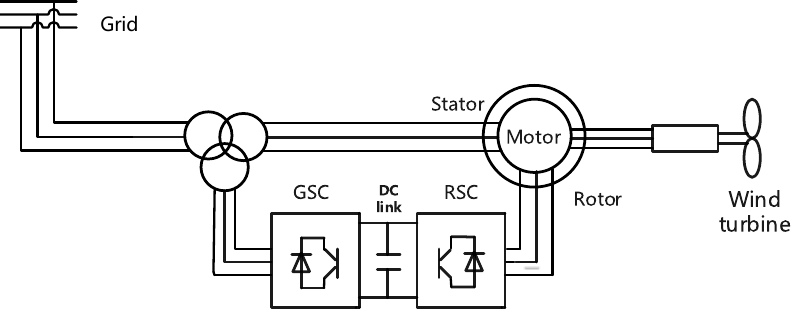
Figure 2. The structure diagram of the double-fed induction generator (DFIG)-based system.